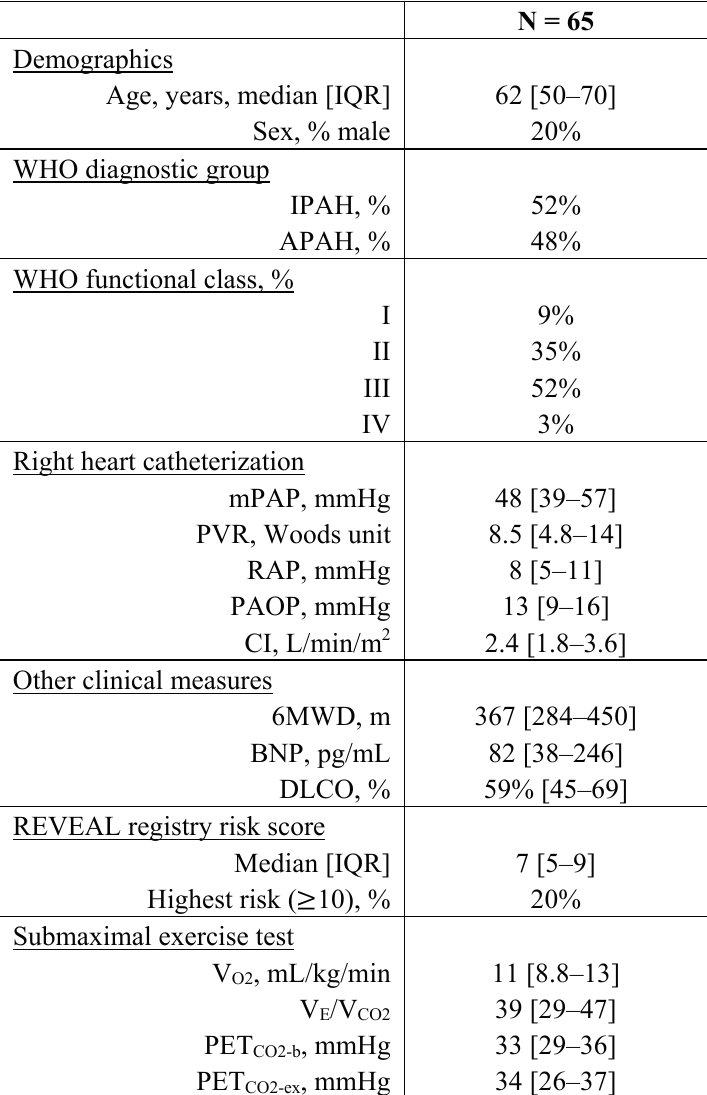
Table 1. Baseline